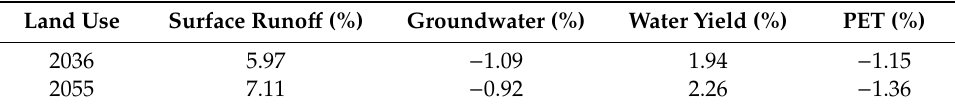
Table 6. Variation of the annual water balance components under